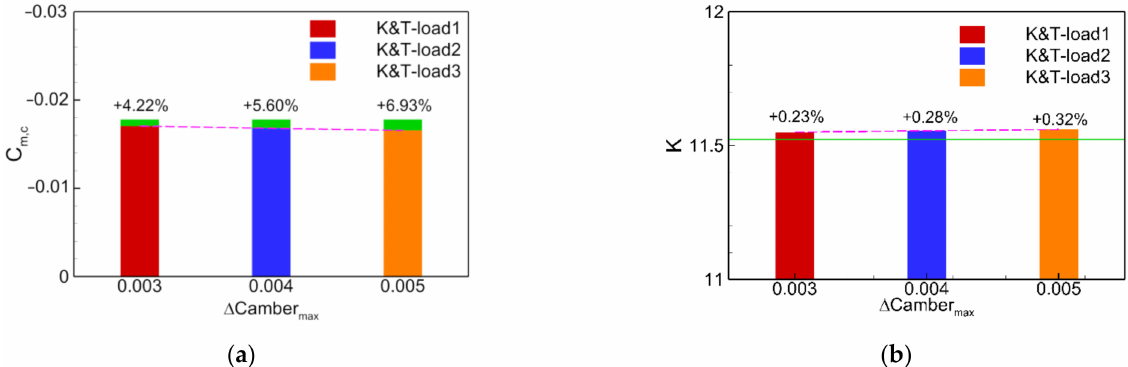
Figure 25. The increments of C m,c and K obtained by fore-loading the kink and tip airfoils at cruise state. ( a ) Pitching moment coefficient; ( b ) Lift-to-drag ratio.